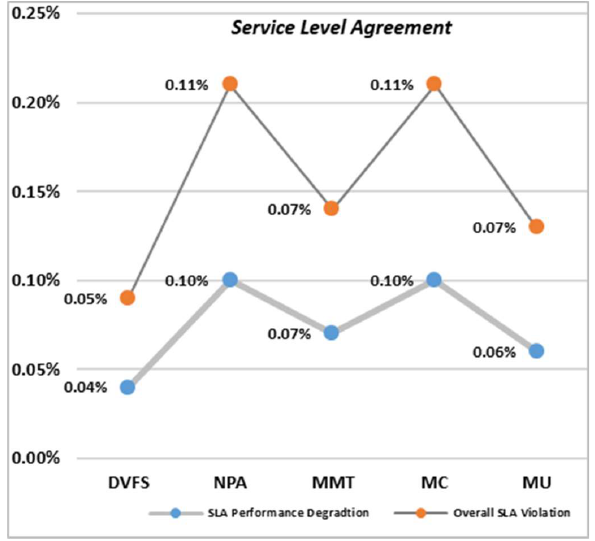
Figure 8. Analysis of the Service Level Agreement Violation.